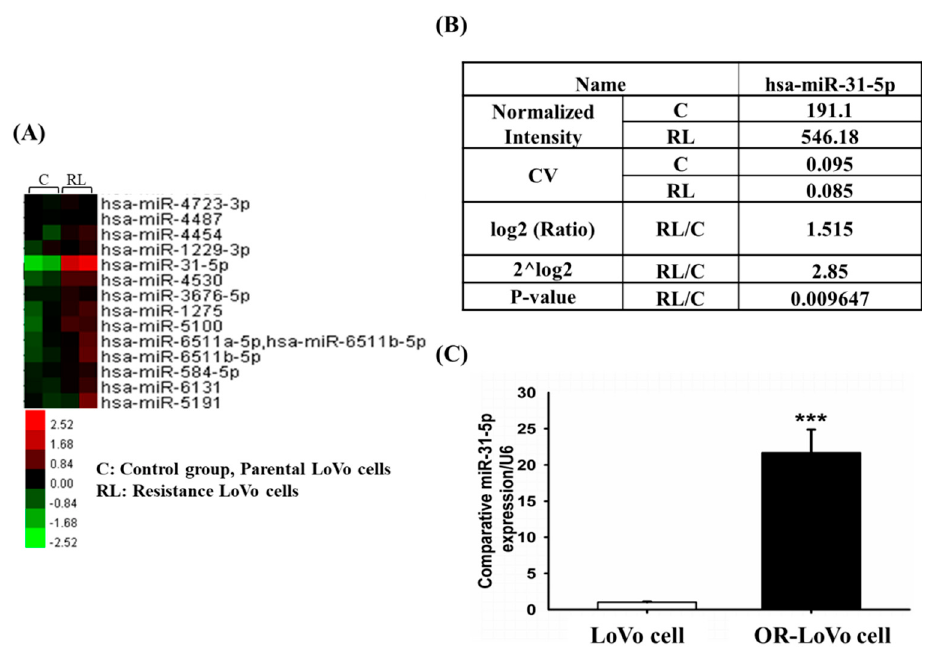
Figure 2. MicroRNA expression in LoVo and OR-LoVo cells. ( A ) MiRNA microarray data analysis, with the red bar indicating upregulated expression and the green bar indicating downregulated expression. ( B ) Detailed miRNA microarray data analysis lists the hsa-miR-31-5p C, RL, or RL / C (C is LoVo cells; RL is OR-LoVo cells) value. C is LoVo cells; RL is OR-LoVo cells. ( C ) Results of the qRT-PCR analysis of the expression levels of miR-31-5p are shown by the bar. *** p < 0.001 vs. LoVo cells.